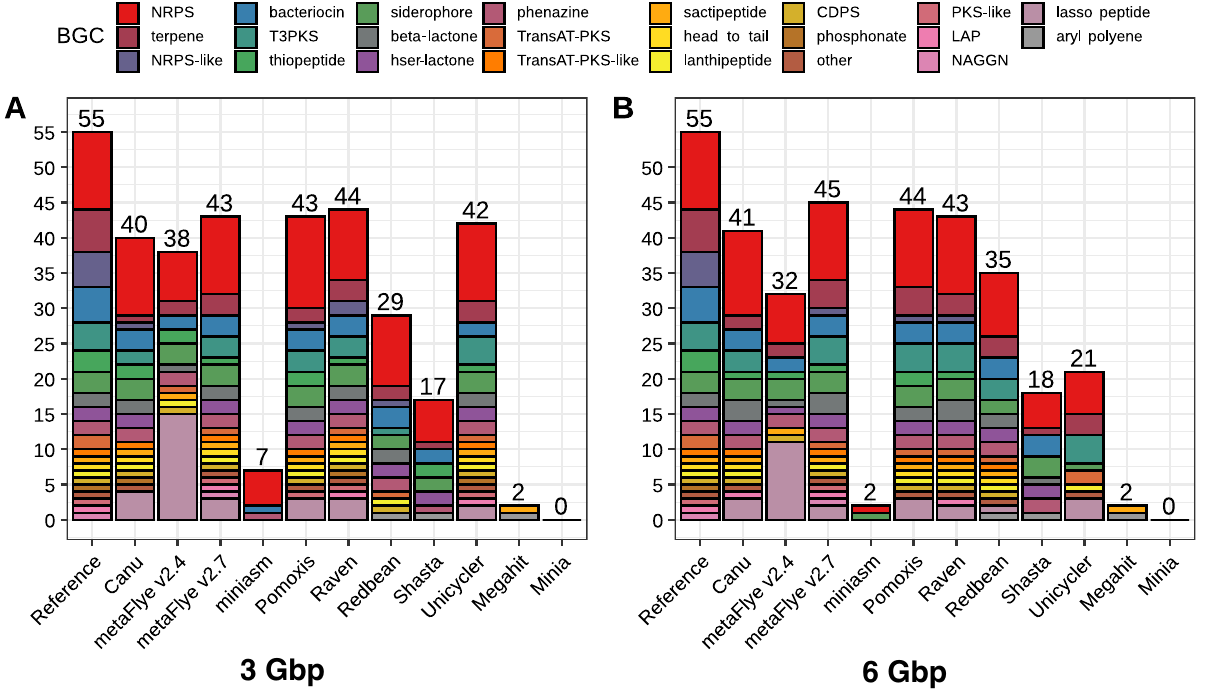
Figure 6. Number of biosynthetic gene clusters (BGCs) predicted by antiSMASH for each draft assembly in the Even GridION datasets. ( A ) BGCs predicted using the 3 Gbp dataset; ( B ) BGCs predicted using the 6 Gbp